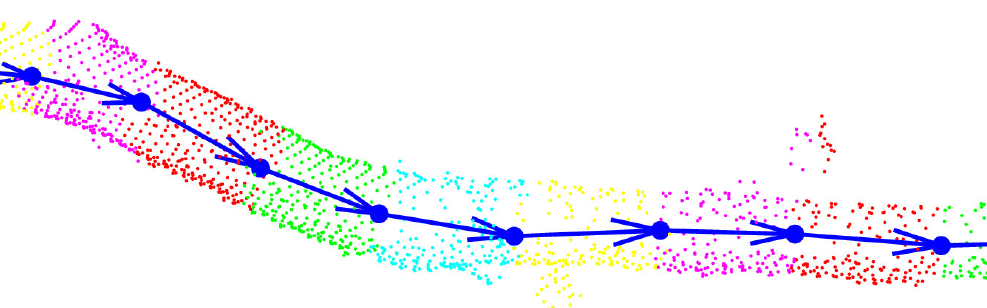
Figure 10. Regions for cylinder fitting. Different colors denote the regions defined by the blue